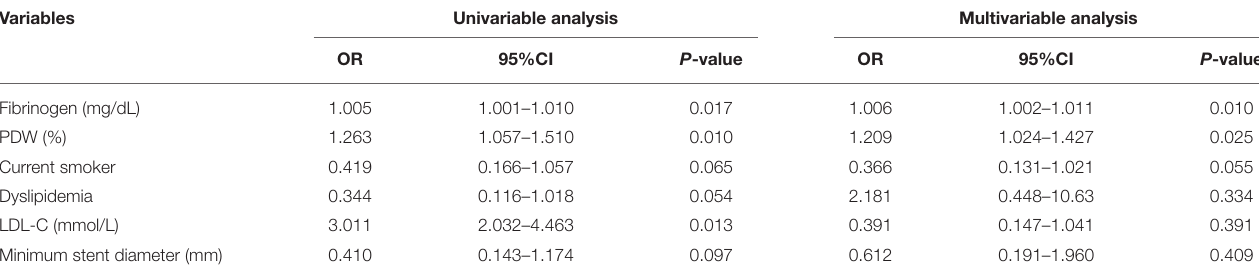
TABLE 3 | The univariate and multivariate logistic regression analysis for predictors of in-stent restenosis (ISR) for patients in prepercutaneous coronary intervention (PCI).